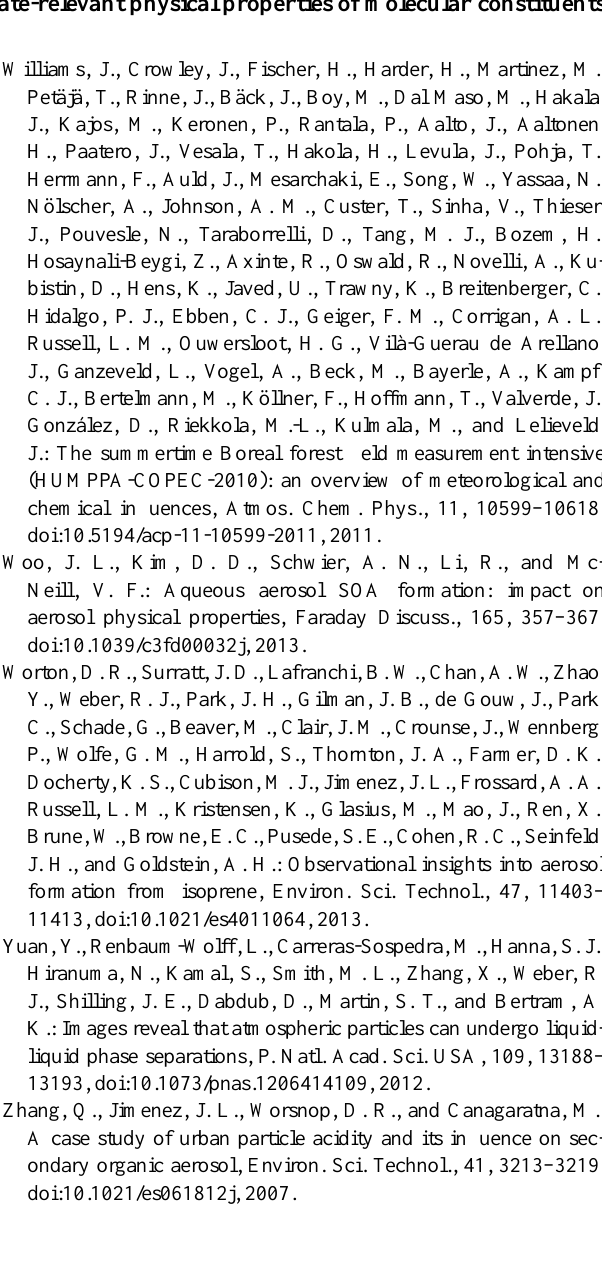
Tabazadeh, A.: Organic aggregate formation in